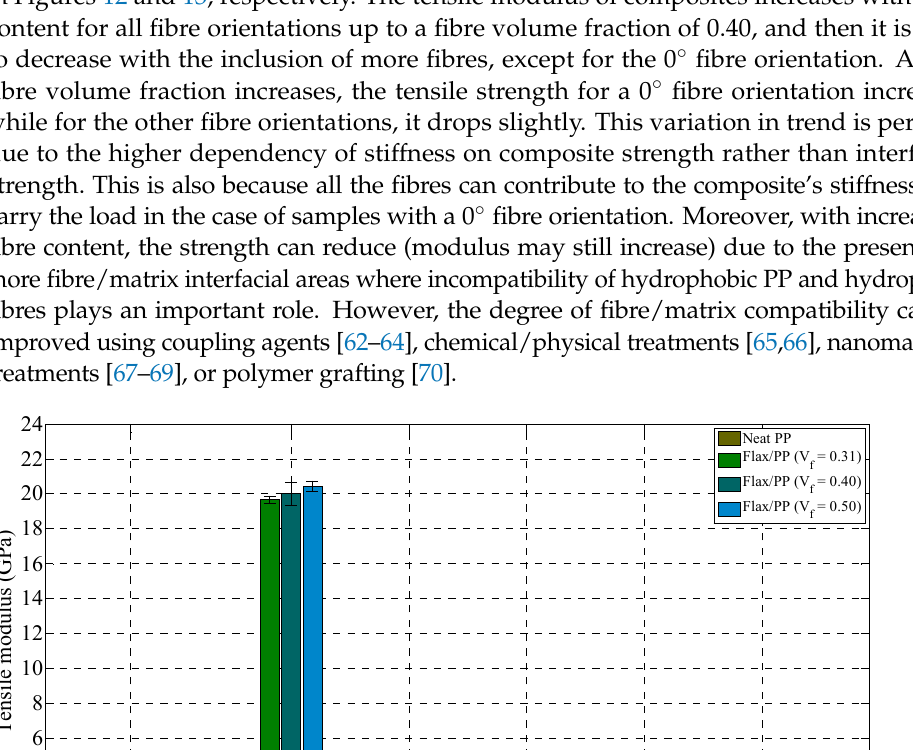
Figure 13. Tensile strength for neat PP and flax/PP samples of different fibre volume fractions and orientations. It is observed from Figures 12 and 13 that the tensile modulus and strength of composites drop significantly between 0° and 30°. However, there is little variation in composite modulus and strength between 45° and 90°. This trend is similar to that stated by other authors [71,72]. The tensile properties of the specimens are highly influenced by the fibre orientation (with respect to the loading direction); for instance, tensile modulus and strength are reduced from 16.66 GPa to 3.36 GPa and 125 MPa to 29 MPa, respectively, at an off-axis angle of 30° ( V f = 0.31). The decrease in composite modulus and strength by increasing fibre orientation is due to the decline in the fibres’ contribution to carrying the applied load. Respectively, the tensile modulus and strength of composites loaded in the 0° fibre orientation ( V f = 0.40) are 13.70 and 8.50 times higher than the tensile modulus and strength of 90° fibre orientation ( V f = 0.40). The minimum tensile properties are found for a 90° fibre orientation, where the properties are dominated by the matrix material rather than the fibres, as the fibres lie perpendicular to the direction of the applied load. The maximum tensile modulus (20.44 GPa) and strength (173.08 MPa) of the samples are, however, observed for a fibre volume fraction and orientation of 0.50 and 0°,